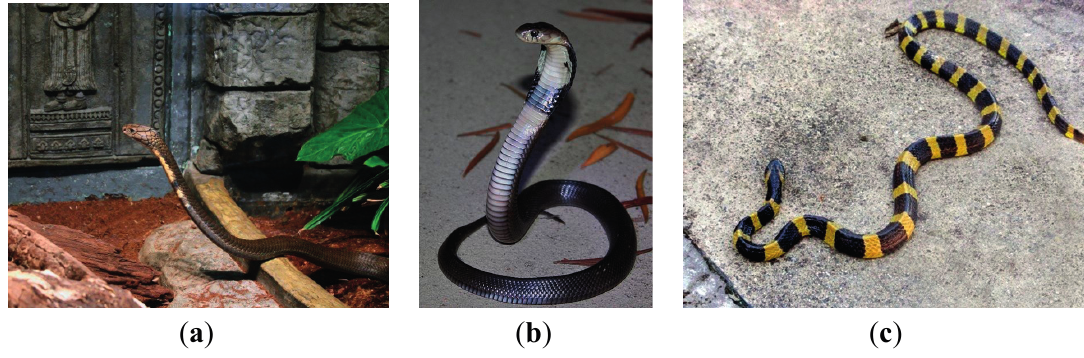
Figure 4 . Elapid snakes ( a ) The King cobra ( O. hannah ) [44] ( b ) A juvenile Chinese cobra